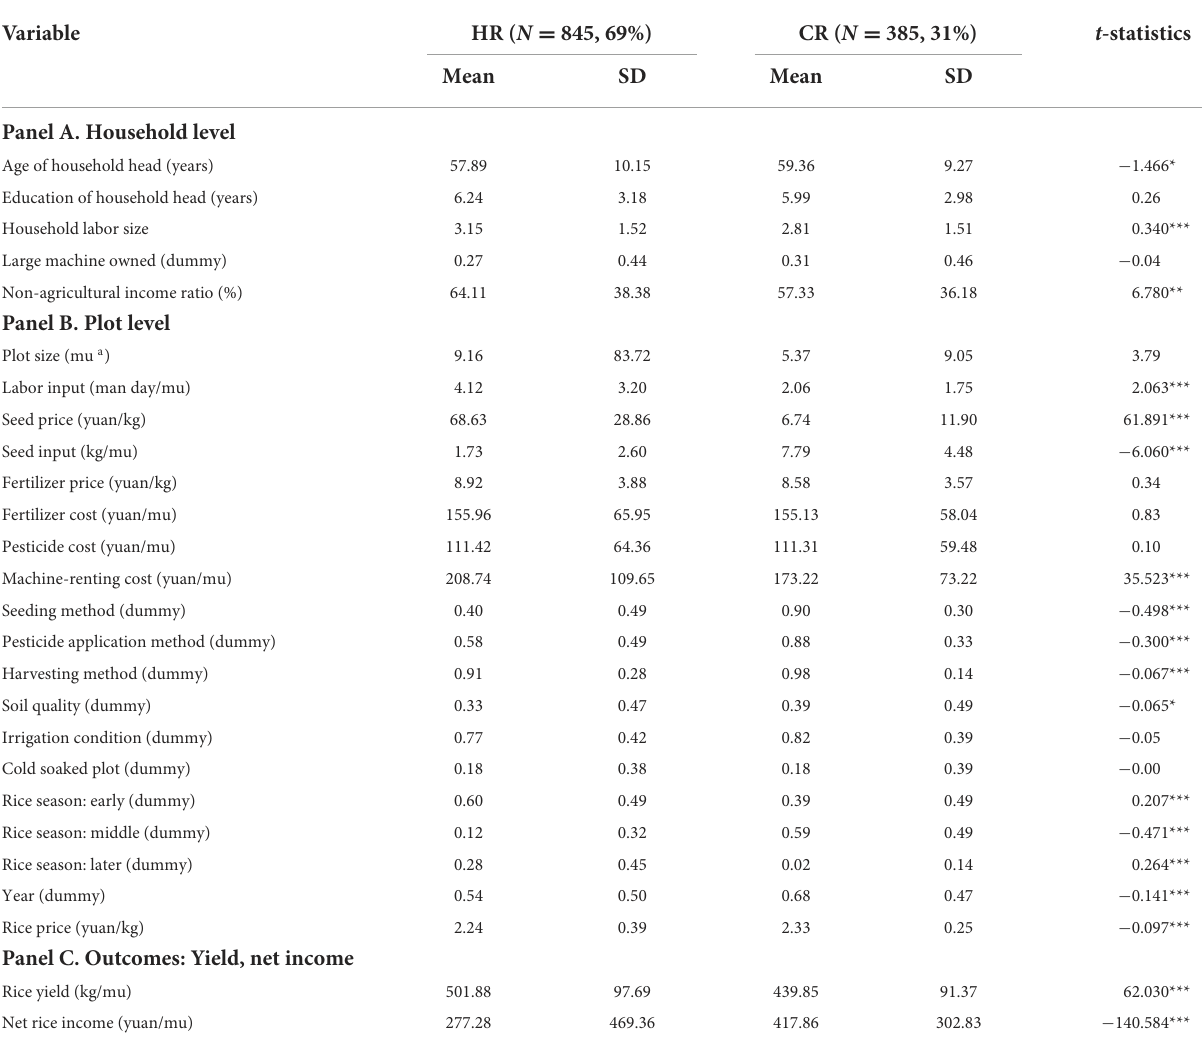
TABLE 1 Variables and summary statistics,